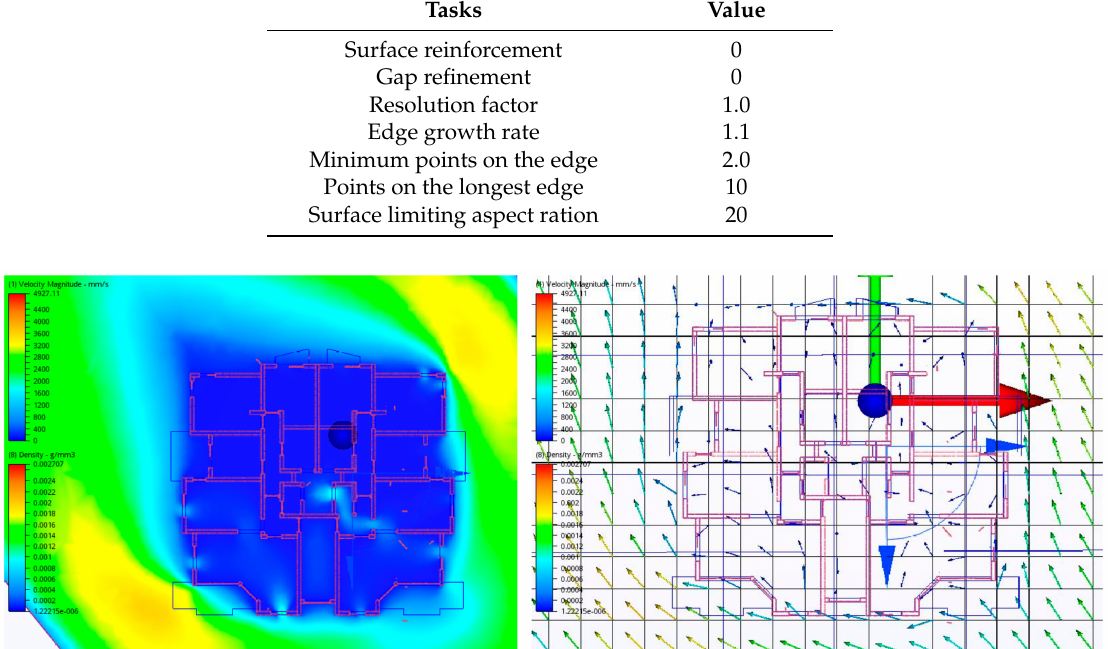
Figure 11. Contour and Grid Vector of air velocity and magnitude, CFD Autodesk 2016.